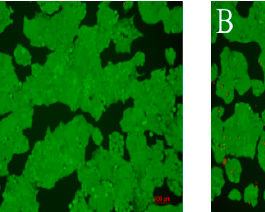
15 of 23 Figure 12. Changes in cell viability of HeLa cells and C n DDGPB cocultured for 48 h. (Note: com- pared with the respective control group). As can be seen in Figure 12, cell survival rate decreased with an increase in carbon chain length at the same concentration. C 10 DDGPB exhibited the lowest toxicity. Dodecyl- dimethylbenzyl ammonium chloride (1227) is a commonly used and efficient broad-spec- trum cationic surfactant. A comparison of the toxicity results of 1227 and C n DDGPB (Fig- ure 12) revealed that the cell survival rate of C n DDGPB was much higher than that of 1227, which suggests that the double-chain glucosamine quaternary ammonium salt is safer than this conventional disinfectant in terms of disinfection and sterilization. The IC 50 val- ues of 1227, C 8 DDGPB, C 10 DDGPB, C 12 DDGPB, C 14 DDGPB and C 16 DDGPB are 3.31 μ g/mL, 10.75 μ g/mL, 13.65 μ g/mL, 9.07 μ g/mL, 8.36 μ g/mL and 9.15 μ g/mL, respectively. The CMC values of C 8 DDGPB, C 10 DDGPB, C 12 DDGPB, C 14 DDGPB and C 16 DDGPB are 48.68 μ g/mL, 60.18 μ g/mL, 76.39 μ g/mL, 109.24 μ g/mL, and 752.59 μ g/mL, respectively. This indicates that the IC 50 value of this kind of quaternary ammonium salt is below the CMC value.